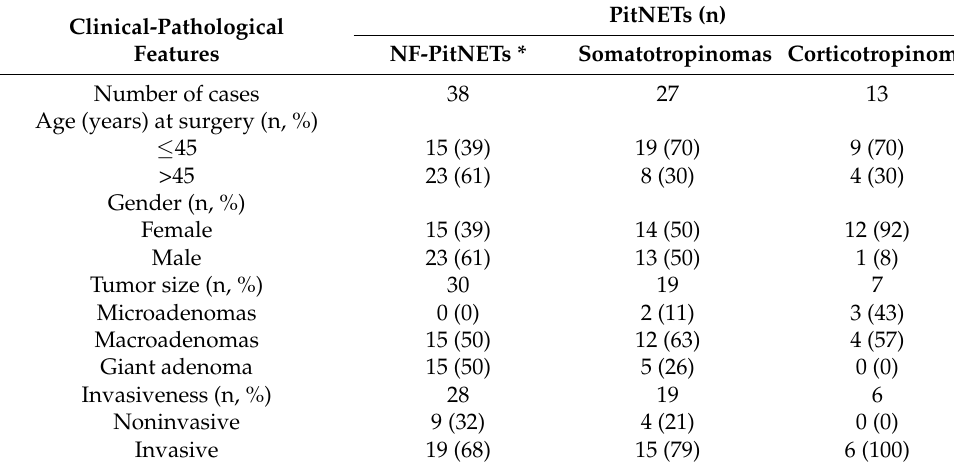
Table 1. Clinical-pathological features of patients with pituitary neuroendocrine tumors (PitNETs).